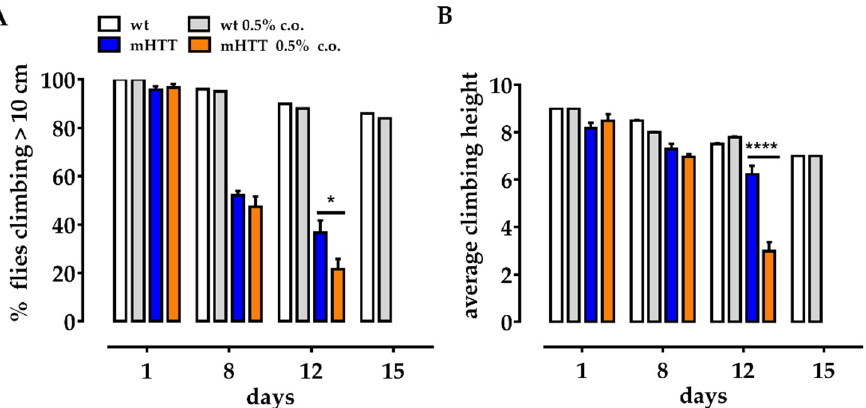
Figure 3. Coconut oil supplementation exacerbates the neurodegenerative phenotype in adult mHTT flies. ( A ) Climbing assay. The percentage of mHTT flies fed a normal diet (mHTT) climbed better than the mHTT flies fed coconut oil (mHTT 0.5% c.o.) 8 and 12 days after eclosion. ( B ) Average height. mHTT flies fed a normal diet reach an average climbing height significantly higher than mHTT 0.5% c.o. 12 days after eclosion in comparison to mHTT age-matched untreated sibling flies.